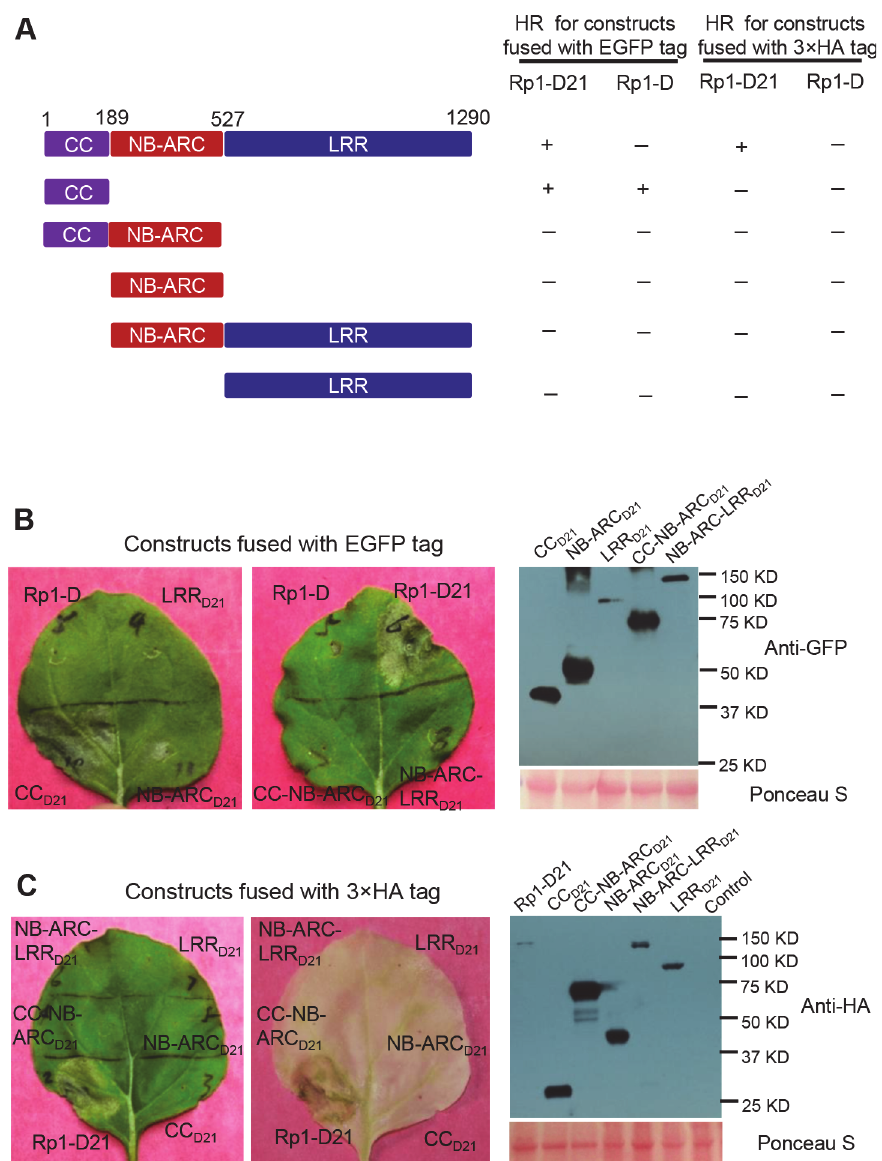
Fig 5. Investigating the functional domains of Rp1-D21 and Rp1-D to trigger a hypersensitive response (HR). (A) Schematic diagram of the Rp1-D21 and Rp1-D domain structure and the derived fragments used for agro-infiltration of N . benthamiana . The different domains are indicated using different colors: CC (purple); NB-ARC (red); LRR (dark blue). The positions of the amino acids that form the domain boundaries are indicated on the top and the abilities to induce (+) or not induce (-) HR are listed on the right of each construct. (B) The HR phenotype of the constructs fused with a C-terminal EGFP tag and transiently expressed in N . benthamiana . Representative leaves were photographed at 3 days post infiltration (dpi, left). Total protein was extracted from agro-infiltrated leaves at 30 hours post infiltration (hpi), and anti-GFP antibody was used to detect the expression of fused proteins. Equal loading of protein samples was shown by Ponceau-S staining of Rubisco subunit (right, below). The results shown were from different domains of Rp1- D21, and similar results were observed from different domains of Rp1-D. (C) The phenotype of the constructs fused with a C-terminal 3×HA tag and transiently expressed in N . benthamiana . A representative leaf was photographed at 3 dpi (left), and the same leaf was cleared by ethanol (middle). Total protein was extracted from agro-infiltrated leaves at 30 hpi, and anti-HA antibody was used to detect the expression of the fused proteins. Equal loading of protein samples was shown by Ponceau-S staining of Rubisco subunit (right). The results shown were from different domains of Rp1-D21, and similar results were observed from different domains of Rp1-D. The experiments were repeated three times with the same